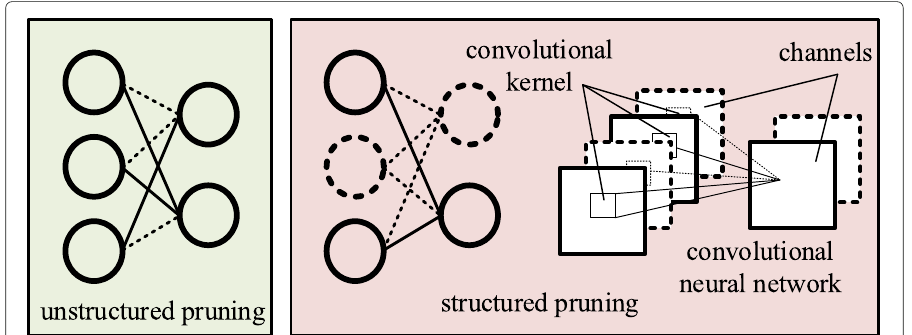
Fig. 1 A high level view of how pruning functions in compressing deep neural networks. Traditional pruning schemes can be divided into two classes, that is, unstructured pruning that simply removes inter-layer connections between neurons while structured pruning removes neurons as well as their connected weights, or channels with their corresponding kernels w.r.t. the convolutional neural